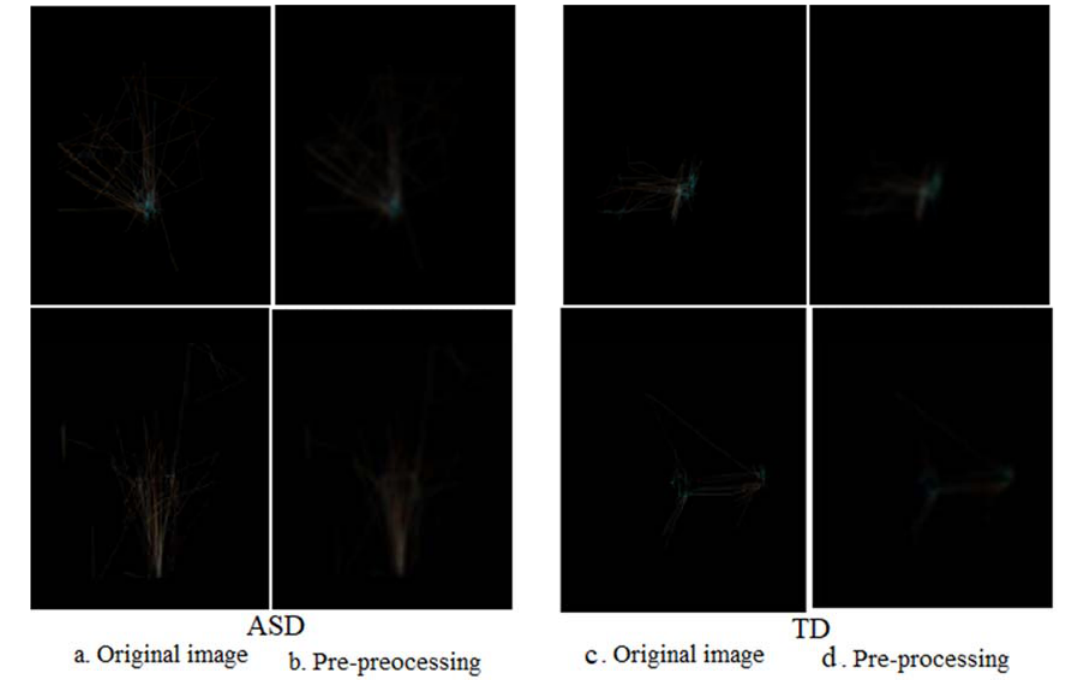
Figure 2. Samples from (ASD and TD dataset. ( a ) SD Original images ( b )Pre–processing ASD images ( c ) TD original images ( d ) Pre–processing TD images